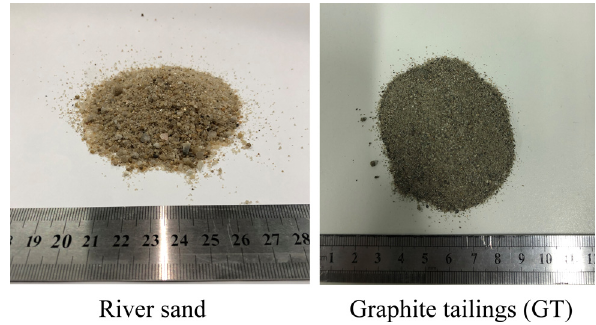
Figure 2: The apparent comparison of GT and